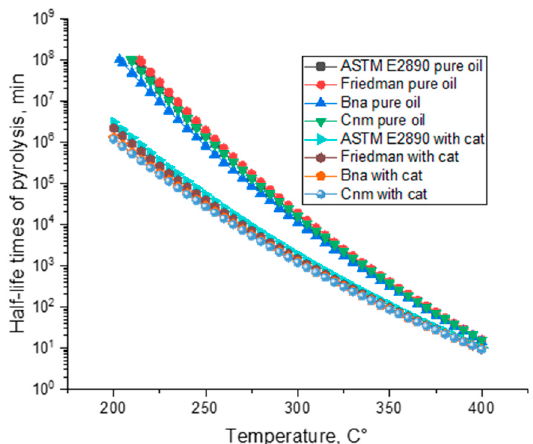
Figure 5. The calculated pyrolysis half-life times from model and non-model approaches at a temperature range of 200 ◦ C to 400 ◦ C in the presence and absence of the